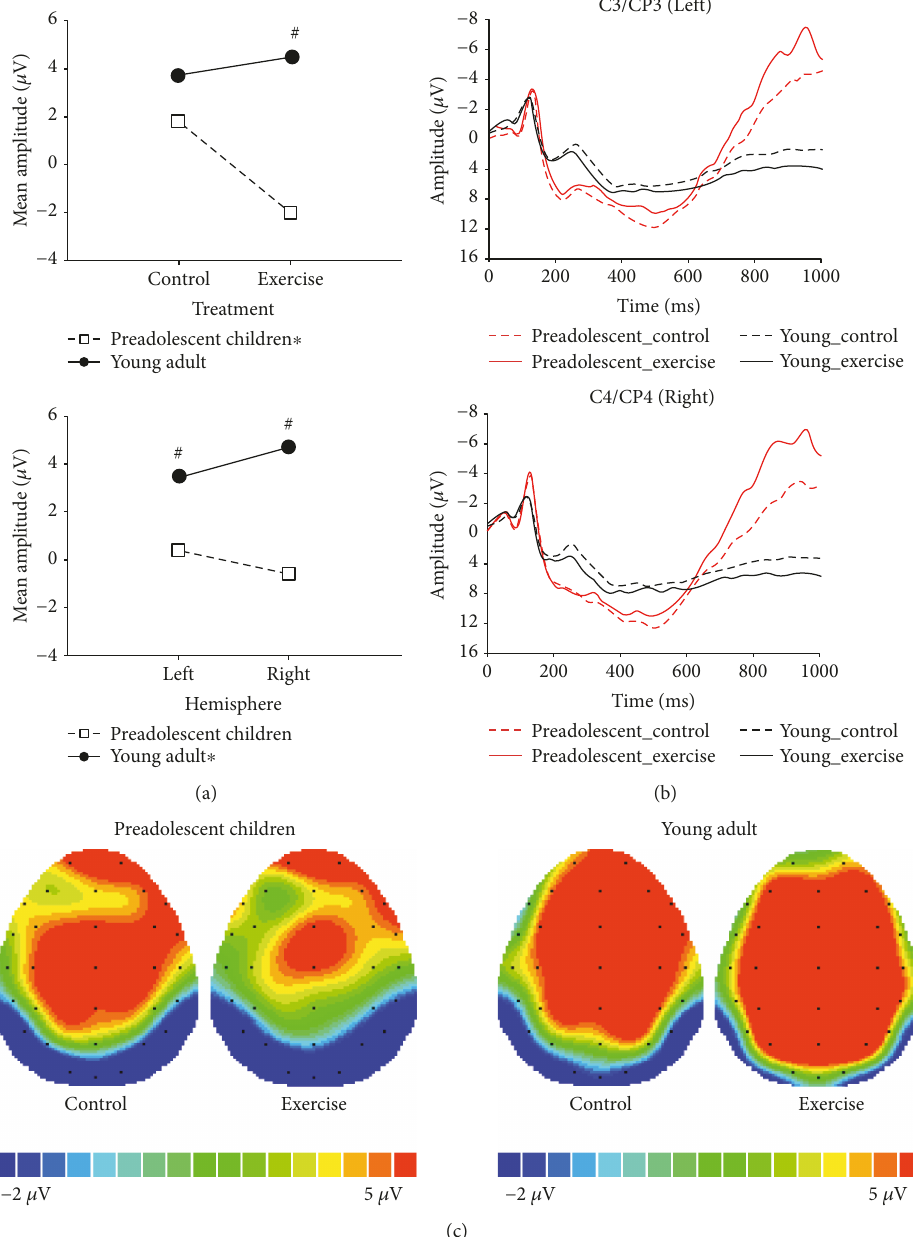
Figure 3: (a) Interaction e ff ect of treatment and group and site and group. ∗ Signi fi cant di ff erence ( p < 0 05 ). (b) Stimulus-locked grand- average waveform at the right and left central-parietal hemisphere collapsed across congruency in treatments and groups. (c) Topographic scalp distribution of the con fl ict SP amplitude collapsed across congruency in treatments and groups. ∗ Signi fi cant di ff erence within a group ( p < 0 05 ); # Signi fi cant di ff erence between groups ( p < 0 05